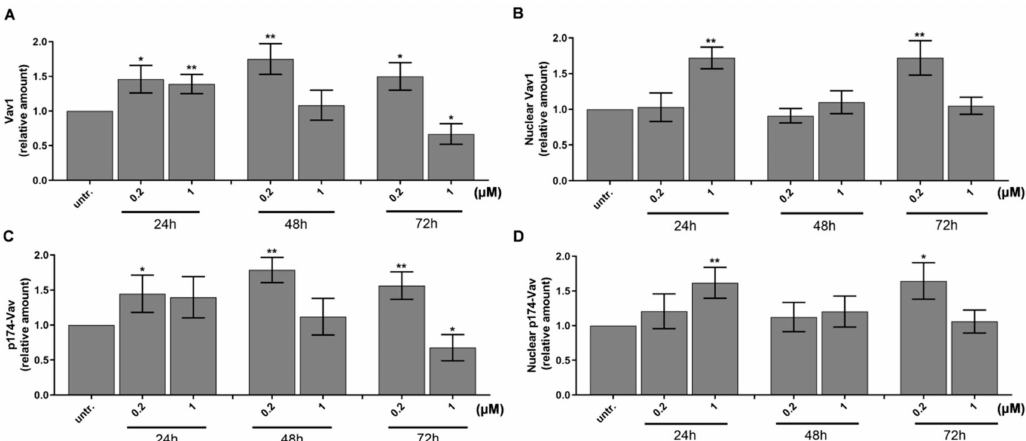
Figure 2. DU325 a ff ects both cellular and nuclear levels of Vav1 in HL-60 cells. Relative levels of Vav1 in whole cells ( A ) and in the nuclei ( B ), and p174-Vav1 (Tyr174) in whole cells ( C ) and in the nuclei ( D ) from HL-60 cells grown in the presence of DU325 at the reported concentrations for the indicated times (h). Cells were assayed as described in the Materials and Methods Section 4.10. The values are deduced from the densitometry of immunochemical bands normalized with β -Tubulin for whole cells or with Lamin B for the nuclei as internal controls of loaded proteins (Figure S2). Data are shown as arithmetic mean values ± standard deviation from triplicate experiments. Statistical significance was calculated in relation to untreated cells and set to * p < 0.05, ** p < 0.01. Mollinedo et al. published that di ff erentiation of HL-60 cells upon stimulation with 1 alpha,25-dihydroxyvitamin D3 required the expression of transcription factor activator protein 1 (AP-1) family members, multiple protein complexes such as FOS and JUN, JUNB, or JUND [49]. The FOS can heterodimerize with JUN members, while the JUN proteins can either homo- or heterodimerize to bind to the target sequences of transcriptionally active DNA elements [50]. We investigated the expression of the AP-1 subunits because both ERK1 / 2 [51,52] and Vav1 can play a role in the activation of the AP-1 pathway [53,54]. We observed a gradual increase in the expression of FOS (4-times, p < 0.001) (Figure 3A), JUN (4-times, p < 0.01) (Figure 3B), and JUND (2.5 × times, p < 0.01) (Figure 3D) after 6 h treatment with 200 nM DU325, while JUNB elevated by 40 nM DU325 after 12 h (1.8 × times, p < 0.01) (Figure